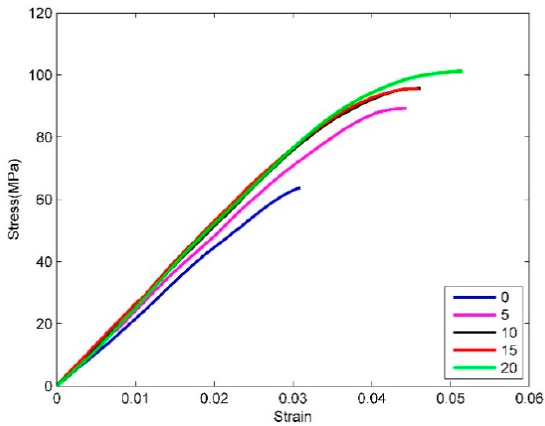
Figure 24. Representative three-point bending test stress-strain curve.